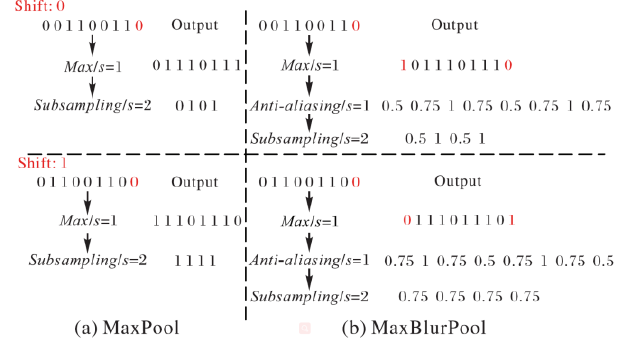
Figure 6. Anti-aliasing operations for one-